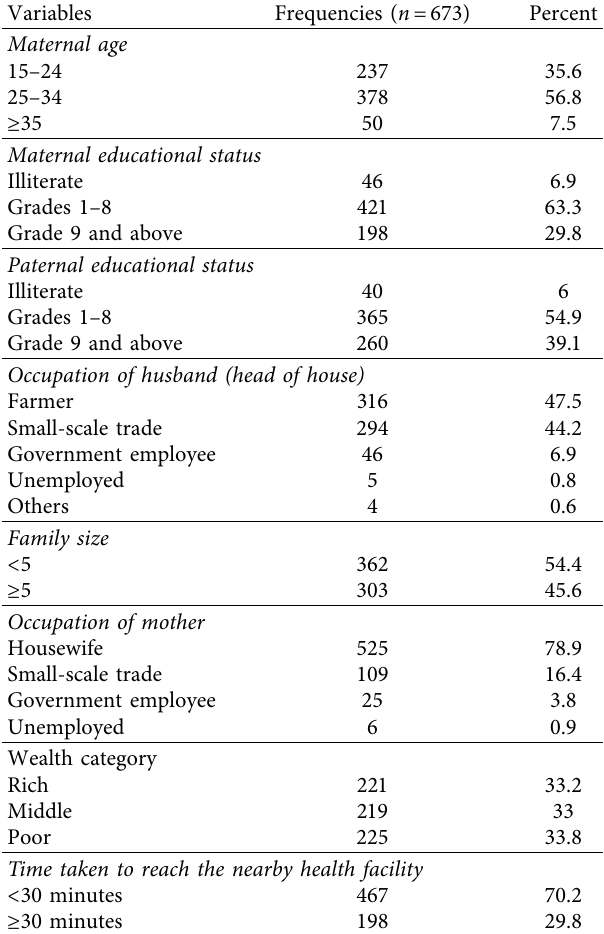
Table 1: Sociodemographic and economic characteristics mothers of children aged 6–59 months in Aleta Chuko woreda, SNNPR, Ethiopia,